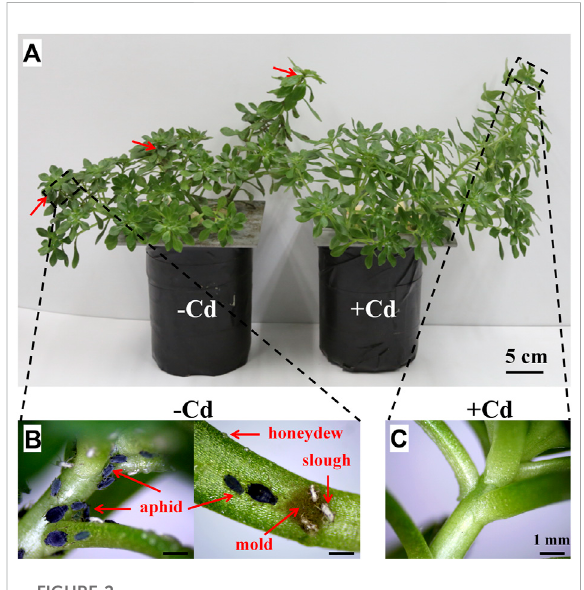
FIGURE 2 Long-term effect of Cd accumulation on the aphid resistanceof theCdhyperaccumulator Sedumalfredii inanopen pathogenic environment. (A) Four-week-old seedlings were treated with 0 (-Cd) or 100 μ mol · dm ⁻ ³ (+Cd) CdCl 2 in a greenhouse full of plants infested by Aphis fabae Scopoli (Hemiptera, Aphididae). After 6 weeks, the control (-Cd, left) plants were colonized by aphids, while very few aphids were observed in Cd-treated (+Cd, right) plants. The red arrow indicates the main site of aphid colonies. (B) Symptoms of aphid attack in the growing tip of control plants. (C) Growing tip of Cd- treated plants. Scale bars: A = 5 cm; B and C = 1 mm.